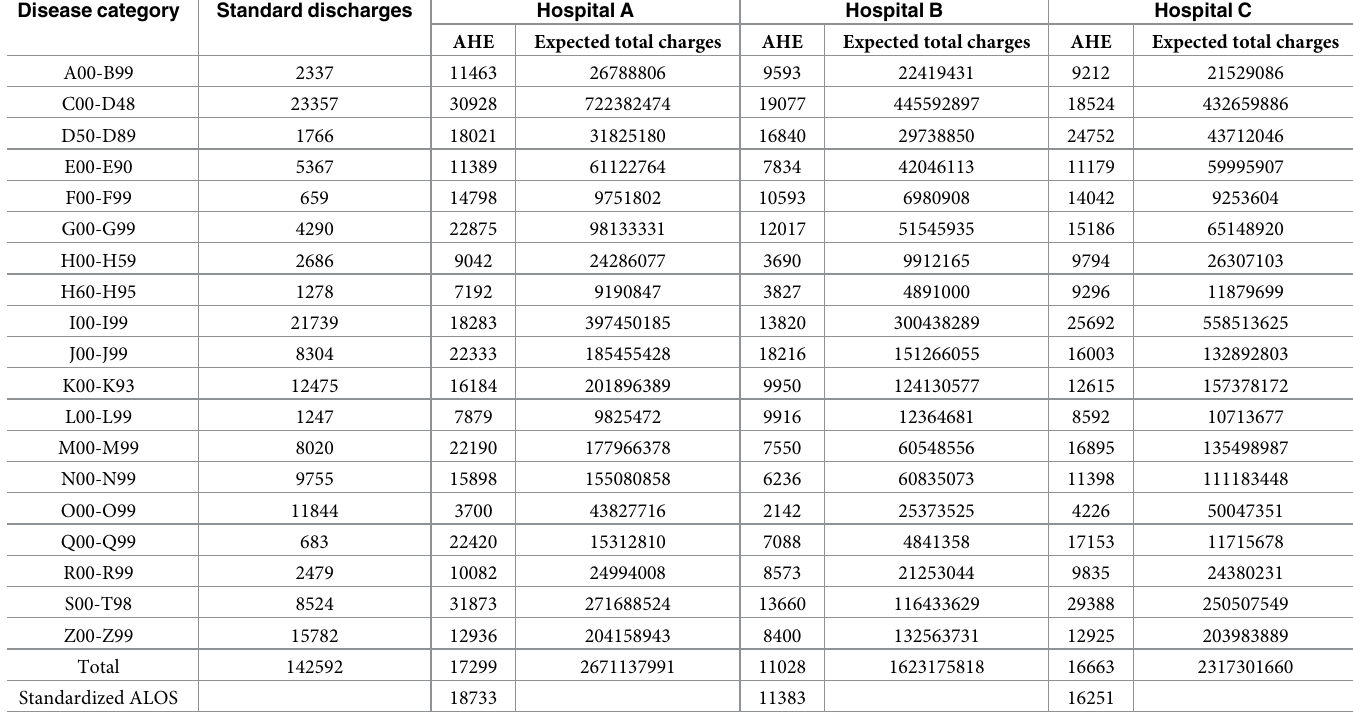
Table 8. The standardized AHE by disease category among three hospitals (CNY). Disease